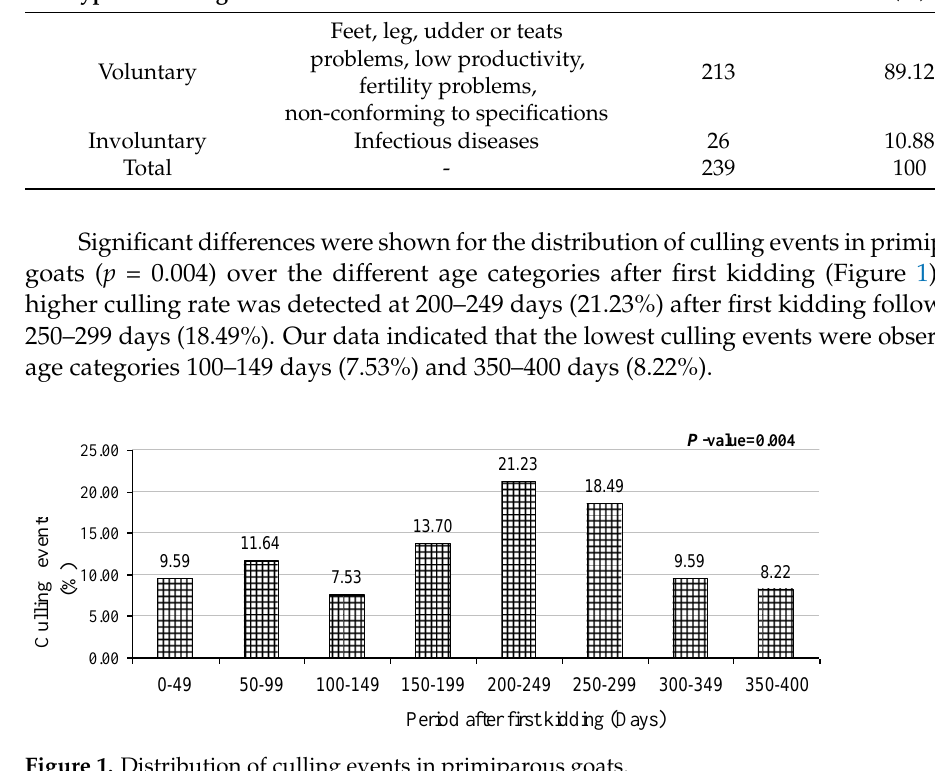
Figure 1. Distribution of culling events in primiparous goats.